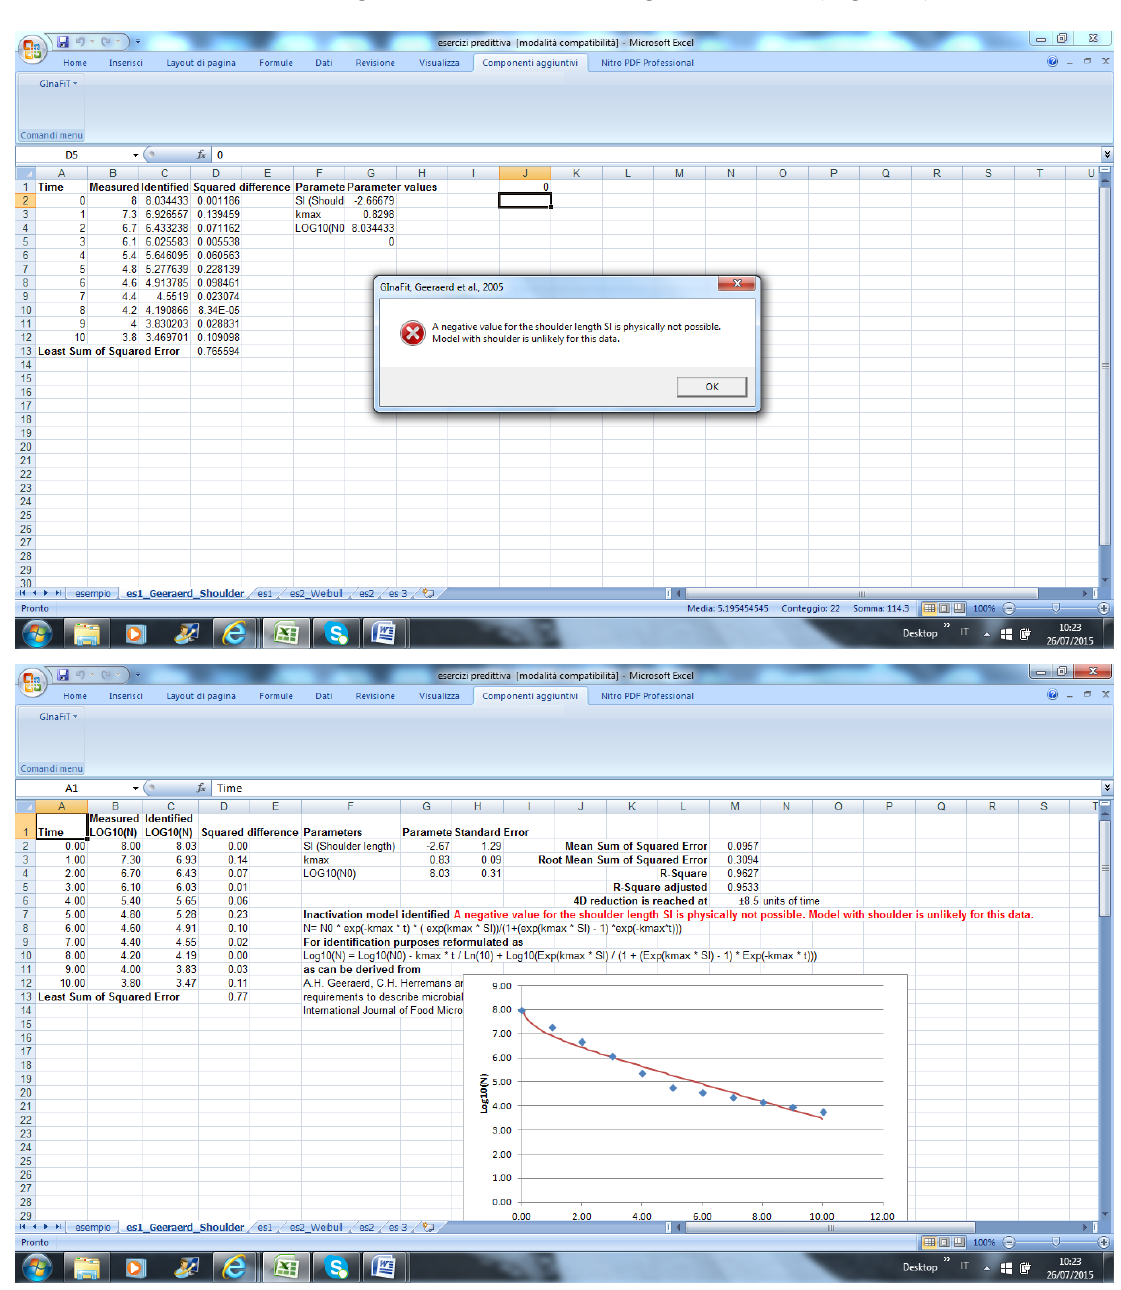
Figure 2. Selection of an incorrect model in